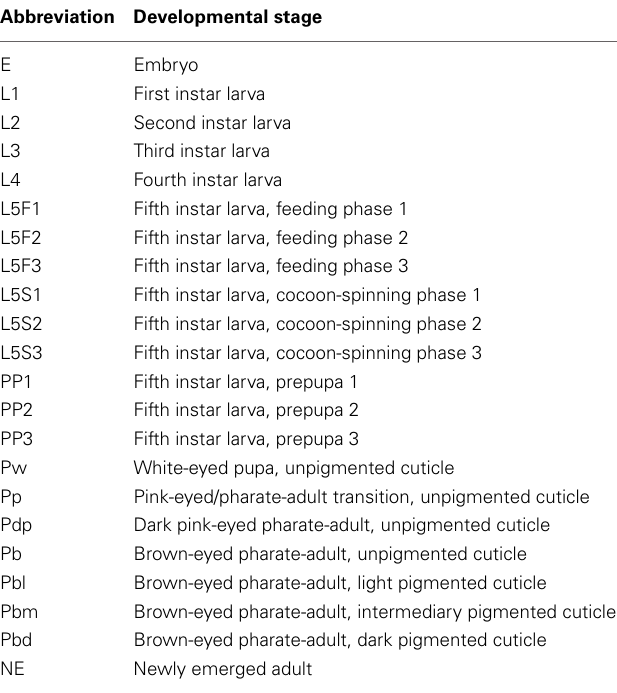
Table 1 | Developmental stages (embryonic, larval, pupal, adult) of A. mellifera considered in this